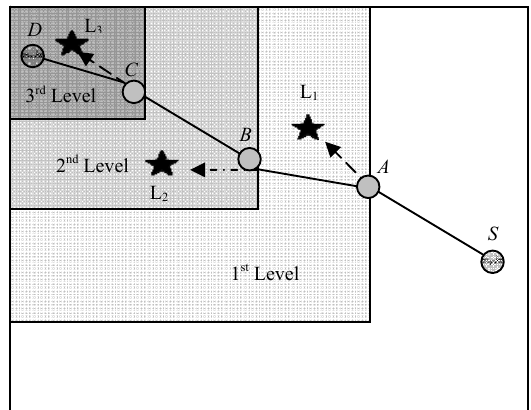
Figure 4. Region Oriented Routing